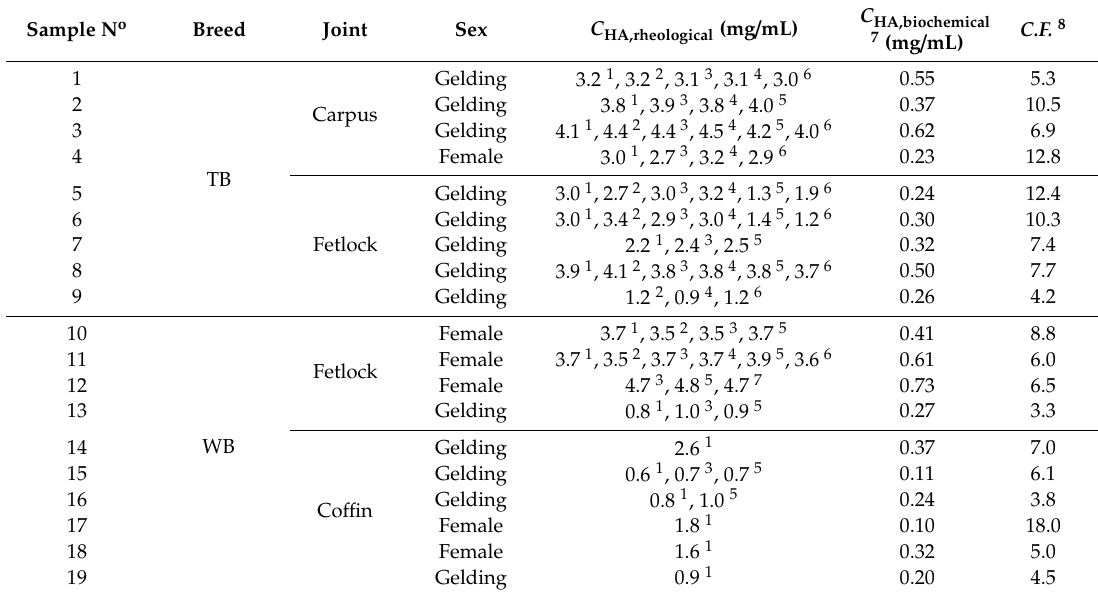
Table A2. Calculated HA concentration in pathological equine SF samples based on SF rheology and on the biochemical ELISA